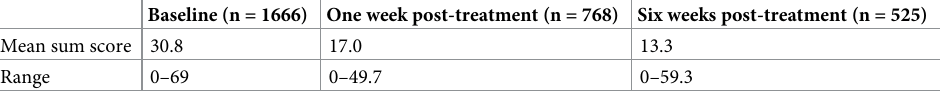
Table 3. BQ data for each data collection